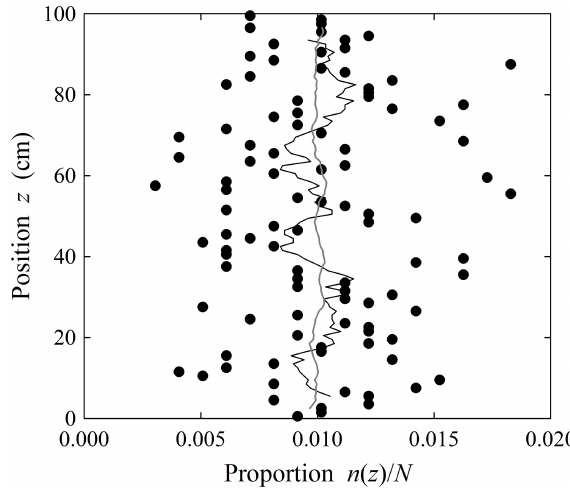
Figure A4. Plot of proportion n ( z ) /N = ˆ f z ( z ) versus position z for the example of N = 1000 particles and X = Y = 1cm with ex- pected proportions of f z ( z )d z = 0 . 01 (black dots), then smoothed with boxcar filter with L = 10cm (black line), and proportion for N = 100000 with X = Y = 10cm and L = 4cm (gray